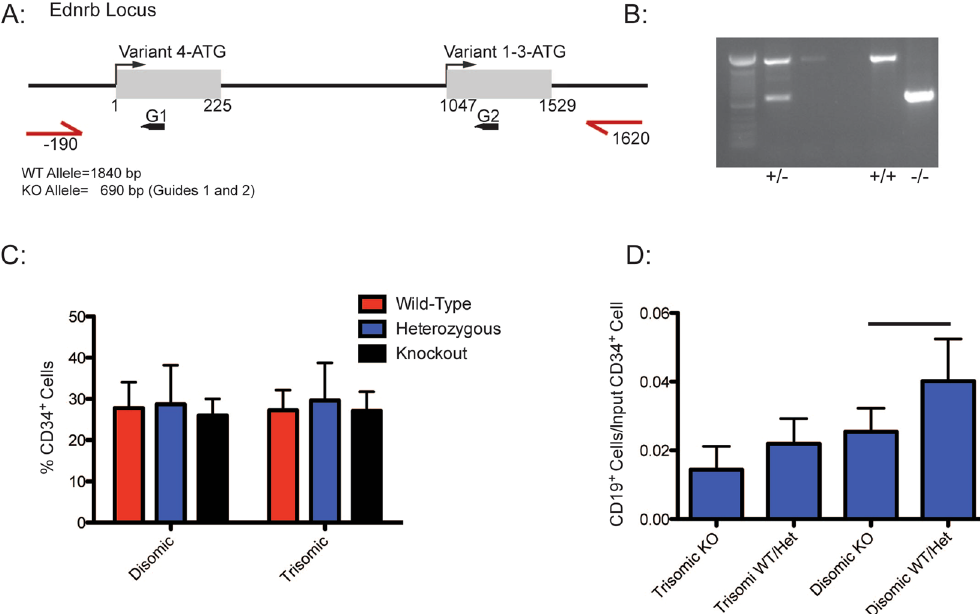
Figure 5. CRISPR/Cas9 Targeting of EDNRB in isogenic iPS cells. ( A ) Structure of the EDNRB locus showing localization of two guides that were used to ablate all 4 isoforms. ( B ) Genotyping of isogenic clones after CRISPR/Cas9 editing showing EDNRB + / + , EDNRB + / − and EDNRB − / − clones. ( C ) FACS analysis for CD34 + generated from Cas9 edited disomic and trisomic isogenic cells. ( D ) Quantification of B cell production in differentiated cells, presented as number of B cells generated per input CD34 + cell (p-value ≤ 0.15, between disomic KO and disomic WT/Het). G1 and G2 refer to two guides that were used for EDNRB